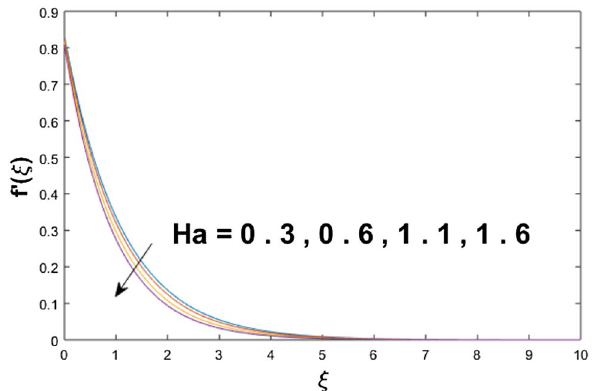
Figure 6. Variations of Ha to f ′ (ξ) .